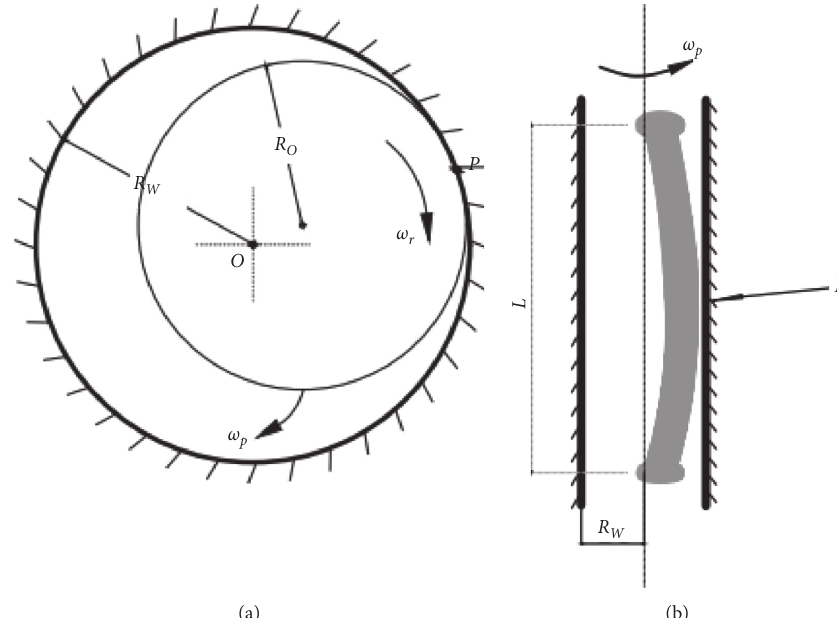
Figure 1: Schematic diagram of whirl. R